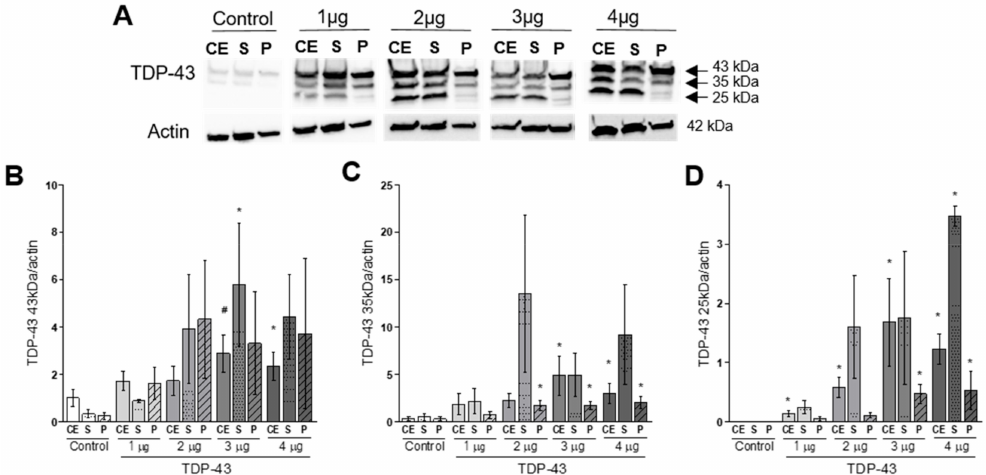
Figure 2. TDP-43 overexpression increases TDP-43 protein full-length (43kDa) presence in soluble and insoluble fractions of cells lysates ( B ) together with the detection of 35- ( C ) and 25-kDa ( D ) C-terminal fragments (CTFs). Representative Western blots are shown in panel ( A ). CE: crude extract; S: soluble fraction; P: insoluble fraction. Nonparametric Kruskal–Wallis test revealed * p < 0.05 and # p = 0.053 compared to the respective control groups (CE x CE; S x S; P x P; n =